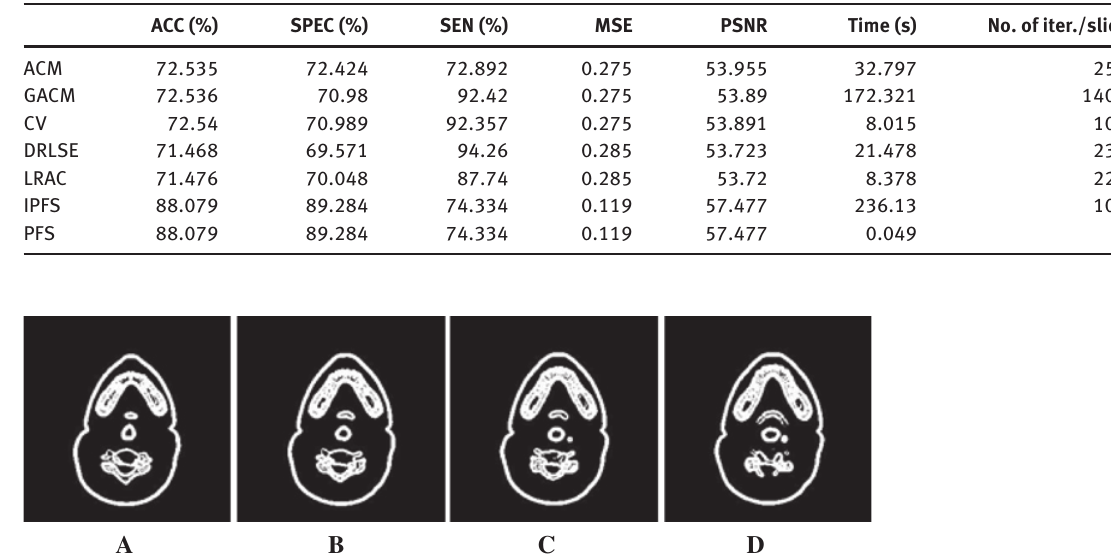
Figure 3: Phase Field segmented results of a human head CT. (A–D) corresponds to segmentation results of images in Figure